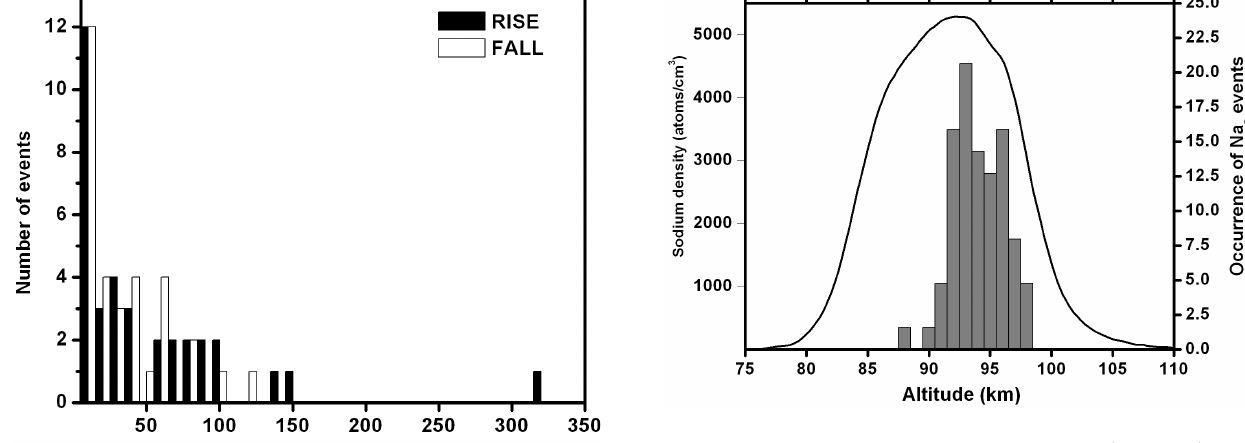
Fig. 7. Height distribution of sporadic Na layers (grey bars) and a one-year averaged (January–December 2005) normal sodium den- sity profile.